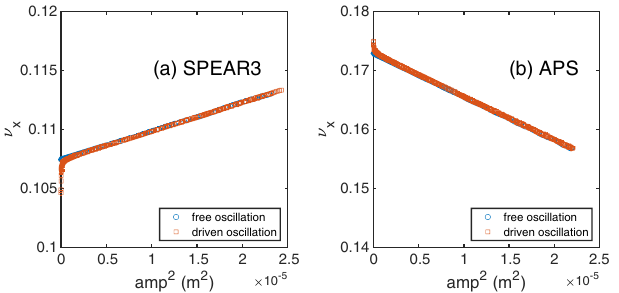
FIG. 6. Comparison of simulations of horizontal tune shift with amplitude between free oscillation and driven oscillation for the (a) SPEAR3 and (b) APS storage rings.